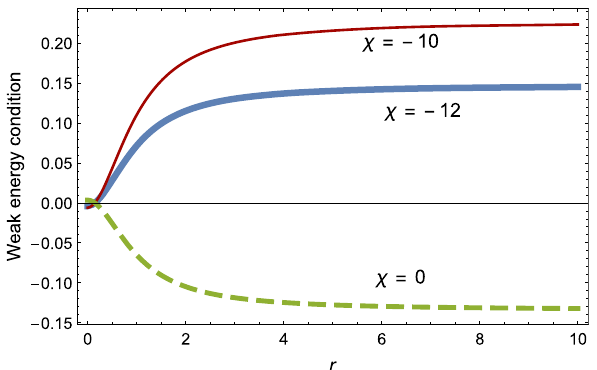
Fig. 7 Mass versus radial value